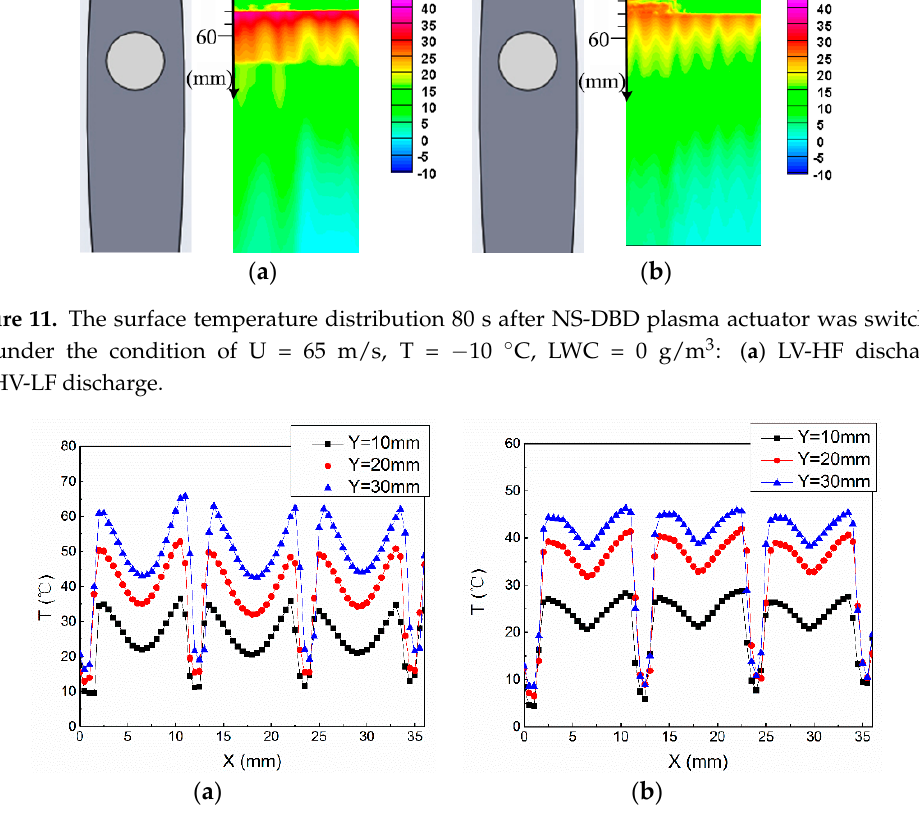
Figure 12. The spanwise (direction of X axis) temperature variation of Y = 10 mm, Y = 20 mm, Y = 30 mm: ( a ) LV-HF discharge; ( b ) HV-LF discharge.